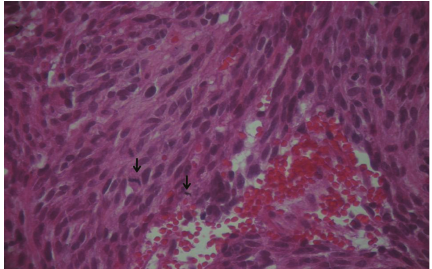
Figure 4: Bone marrow biopsy: Spindle cells with high cellularity. Some of the tumor cells show mild pleomorphism. Numerous mitotic figures are present ( (cid:2) ) (hematoxylin and eosin: ×